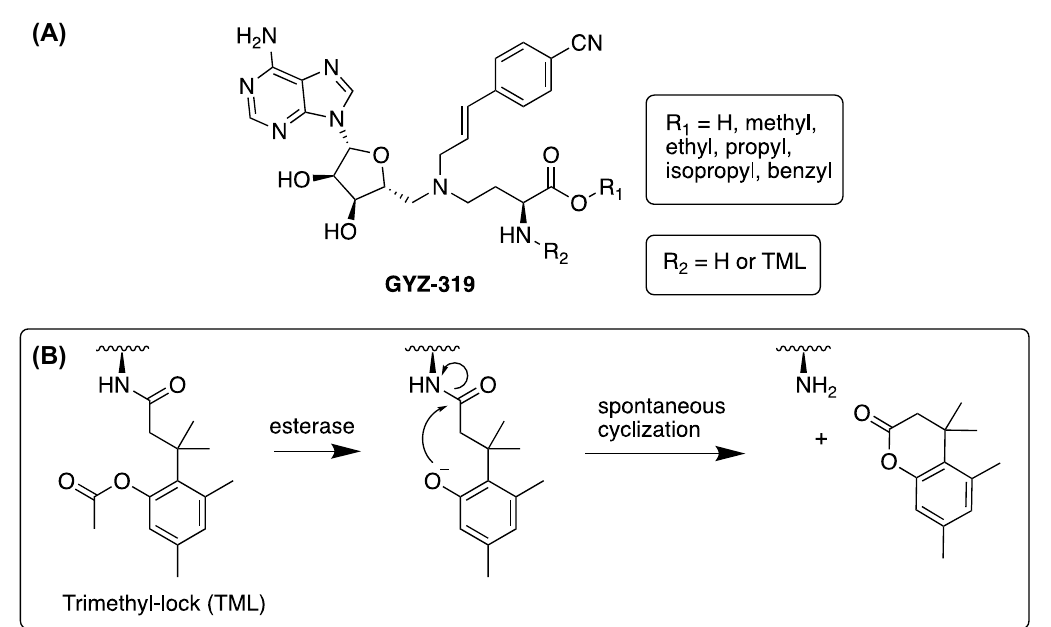
Figure 1. ( A ) Prodrug strategy of compound GYZ-319. The carboxylic acid can be masked as an ester and the amine can be masked as an amide using the esterase-sensitive trimethyl-lock (TML). ( B ) The mechanism of the trimethyl-lock cleavage. Deacetylation by esterases results in spontaneous lactonization, releasing the free amine.